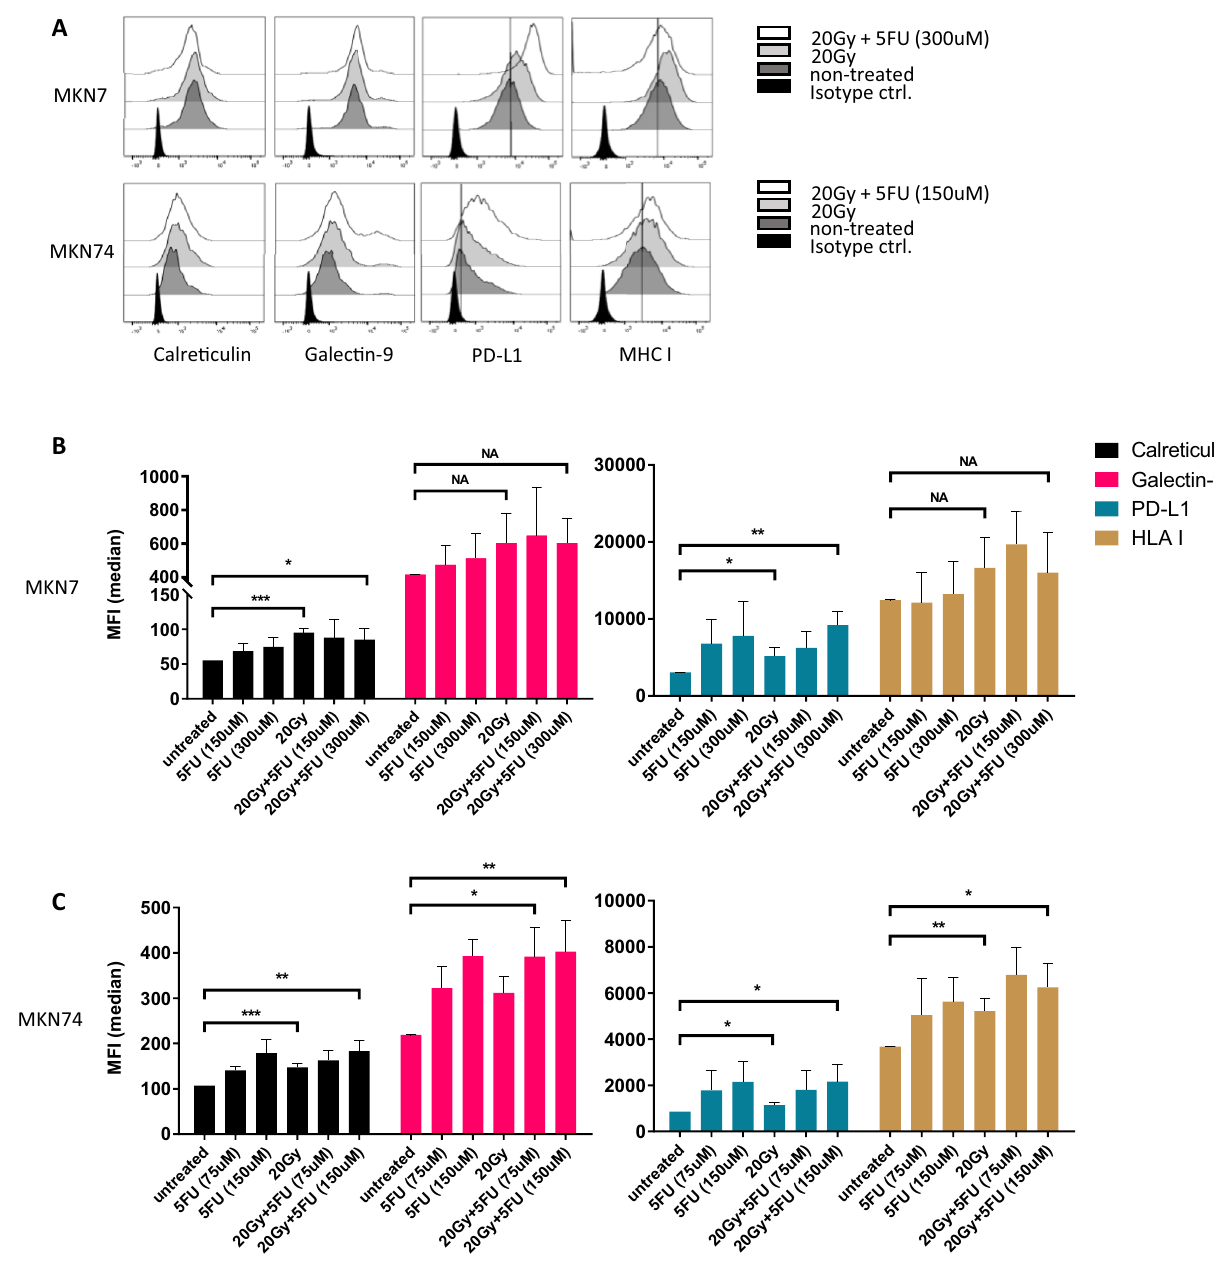
Figure 3. MKN7 and MKN74 elicit cell cycle arrest and upregulation of CRT, Gal-9 and PD-L1. MKN7 and MKN74 cells were treated with 75 μM, 150 μM or 300 μM 5FU, 20 Gy of X-ray irradiation or combinations of these. 48 h after treatment they were stained using PI and AnnexinV to analyze apoptosis or PI in permeabilized cells to analyze cell cycle phase. Surface proteins were stained and analyzed by flow cytometry as above. ( A ) Surface protein expression in MKN7 and MKN74 after radiation or chemoradiation treatment. ( B ) Bar graph of MFI of surface protein expression in MKN7 and ( C ) MKN74 cells. Bar graphs display the mean and SEM of at least 3 biological replicates. *P < 0.05, **P < 0.01, ***P < 0.001, NA not of 20 Gy of radiation. After 48 h, immature Mo-DCs were mixed with the treated GC cells. These cells were co- cultured for an additional 72 h after which we measured the surface expression of the maturation markers CD40, CD80 and CD86 on DCs by flow cytometry. All three markers were upregulated upon maturation using com- mercial maturation medium as a positive control condition (Fig. 4A,B). The same trend can be seen for imma- ture Mo-DC co-cultured with treated GCs (Fig. 4A,B). Dimensionality reduction analysis using t-distributed stochastic neighbor embedding (t-SNE) on concatenated biological replicates helped us visualize the overall level of maturation in Mo-DCs (Fig. 4B). Gating for CD80 and CD86 expressions, we see a clear shift from predominantly CD80 − CD86 − cells in immature Mo-DCs towards a strong CD80 and/or CD86 expression in mature Mo-DCs. Co-culture with MKN7 cells, treated or untreated, had no significant effect on Mo-DC. Adding